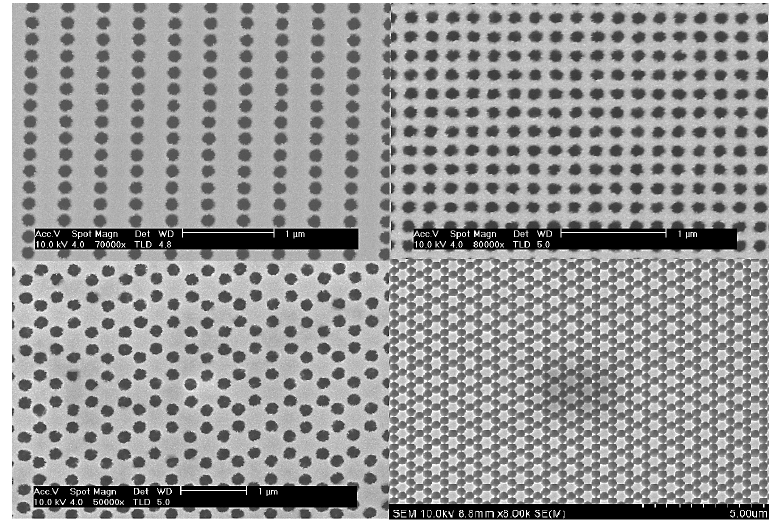
Figure 1. Scanning Electron Micrograph of superconducting Nb film with four geometries: top left-right (rectangular-square), bottom left-right